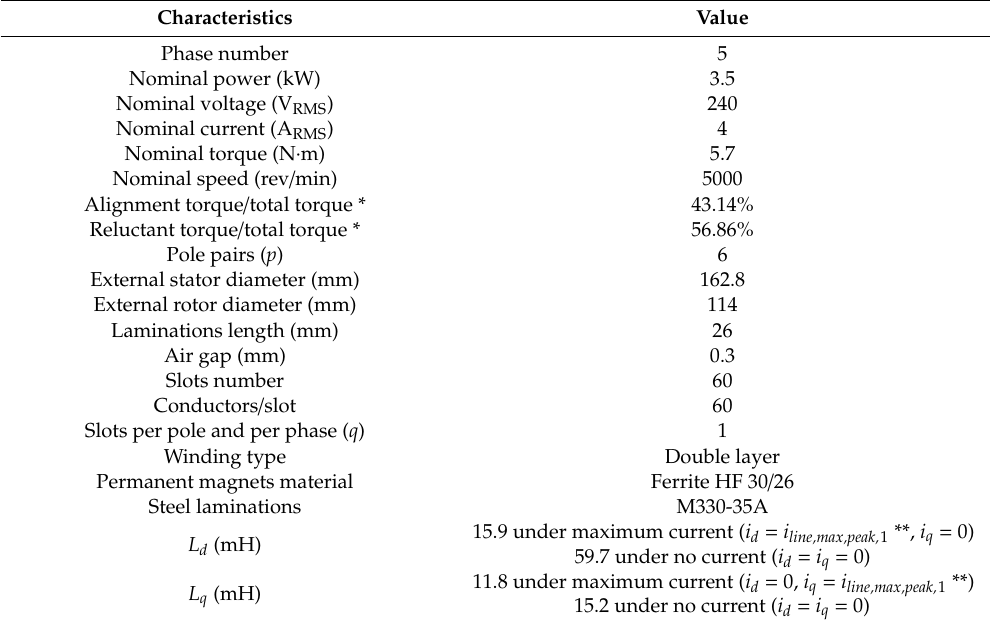
Table 1. Main features of the analyzed fPMa-SynRM.